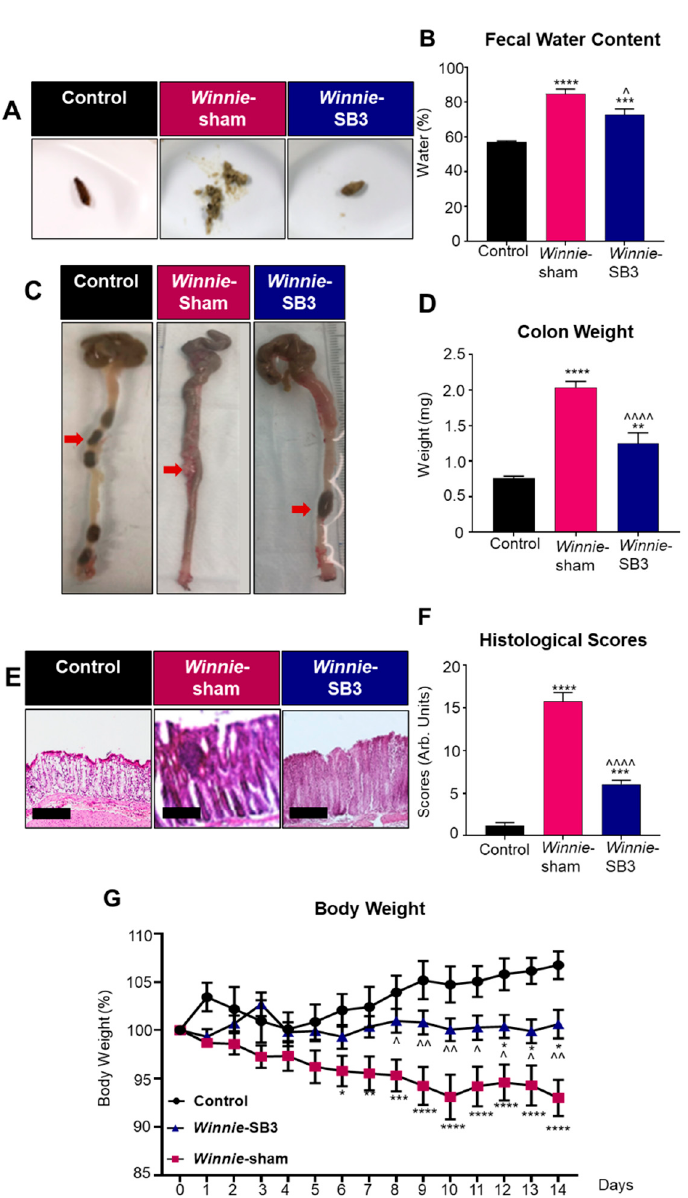
Figure 1. The effects of SB3 treatment on disease activity in Winnie mice. ( A ) Representative images of solid fresh fecal pellets from C57BL/6 healthy controls, loose and watery fecal masses from sham-treated Winnie mice, and improved fecal pellet formation after 14 days of SB3 treatment of Winnie mice. ( B ) The percentage of fecal water content (difference between wet and dry weight) was measured on day 14 of treatments ( n = 6/group). ( C ) Images of colons showing soft contents in sham-treated Winnie mice compared to C57BL/6 controls and SB3-treated Winnie mice (red arrows). ( D ) Weights (mg) of the colons from C57BL/6 control ( n = 8), sham-treated ( n = 10), and SB3-treated ( n = 8) Winnie mice were measured on day 15. ( E ) H&E-stained colon cross-sections from C57BL/6 control, sham-treated, and SB3-treated Winnie mice. Scale bar 20 µm. ( F ) Histological scores (arbitrary units) determined by quantification of gross morphological parameters in the colon ( n = 7/group). ( G ) Measurements of body weights in C57BL/6 control ( n = 11), sham-treated ( n = 12), and SB3-treated ( n = 11) Winnie mice over the 14-day treatment period. Data expressed as mean ± SEM, * p < 0.05, ** p < 0.01, *** p < 0.001, **** p < 0.0001 compared to C57BL/6 control mice; ^ p < 0.05, ^^ p < 0.01, ^^^^ p < 0.0001 compared to Winnie -sham treated mice.